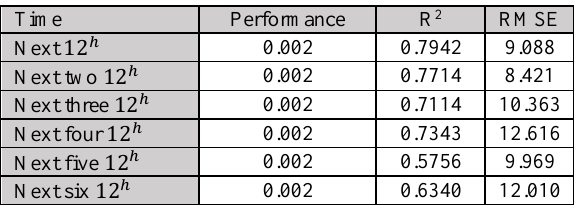
Table 4. The estimated